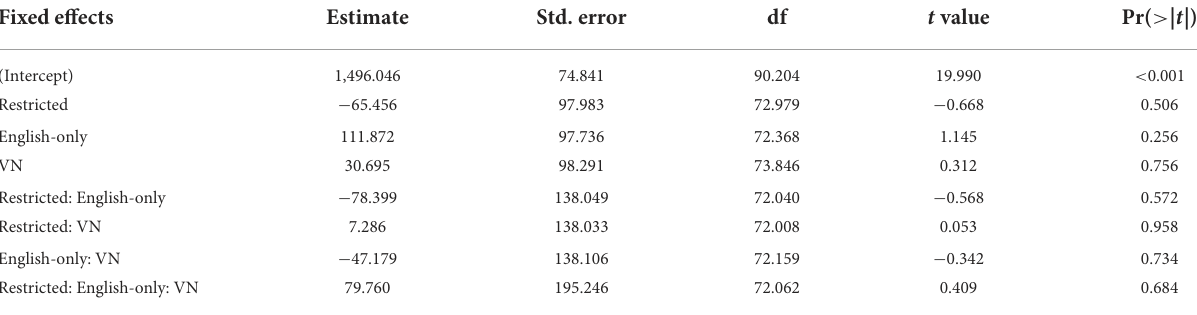
TABLE 5 RT results of a mixed model comparing L1-L2 congruency for type and restriction (congruent, AN, and free as reference categories) for NNSs. Fixed effects